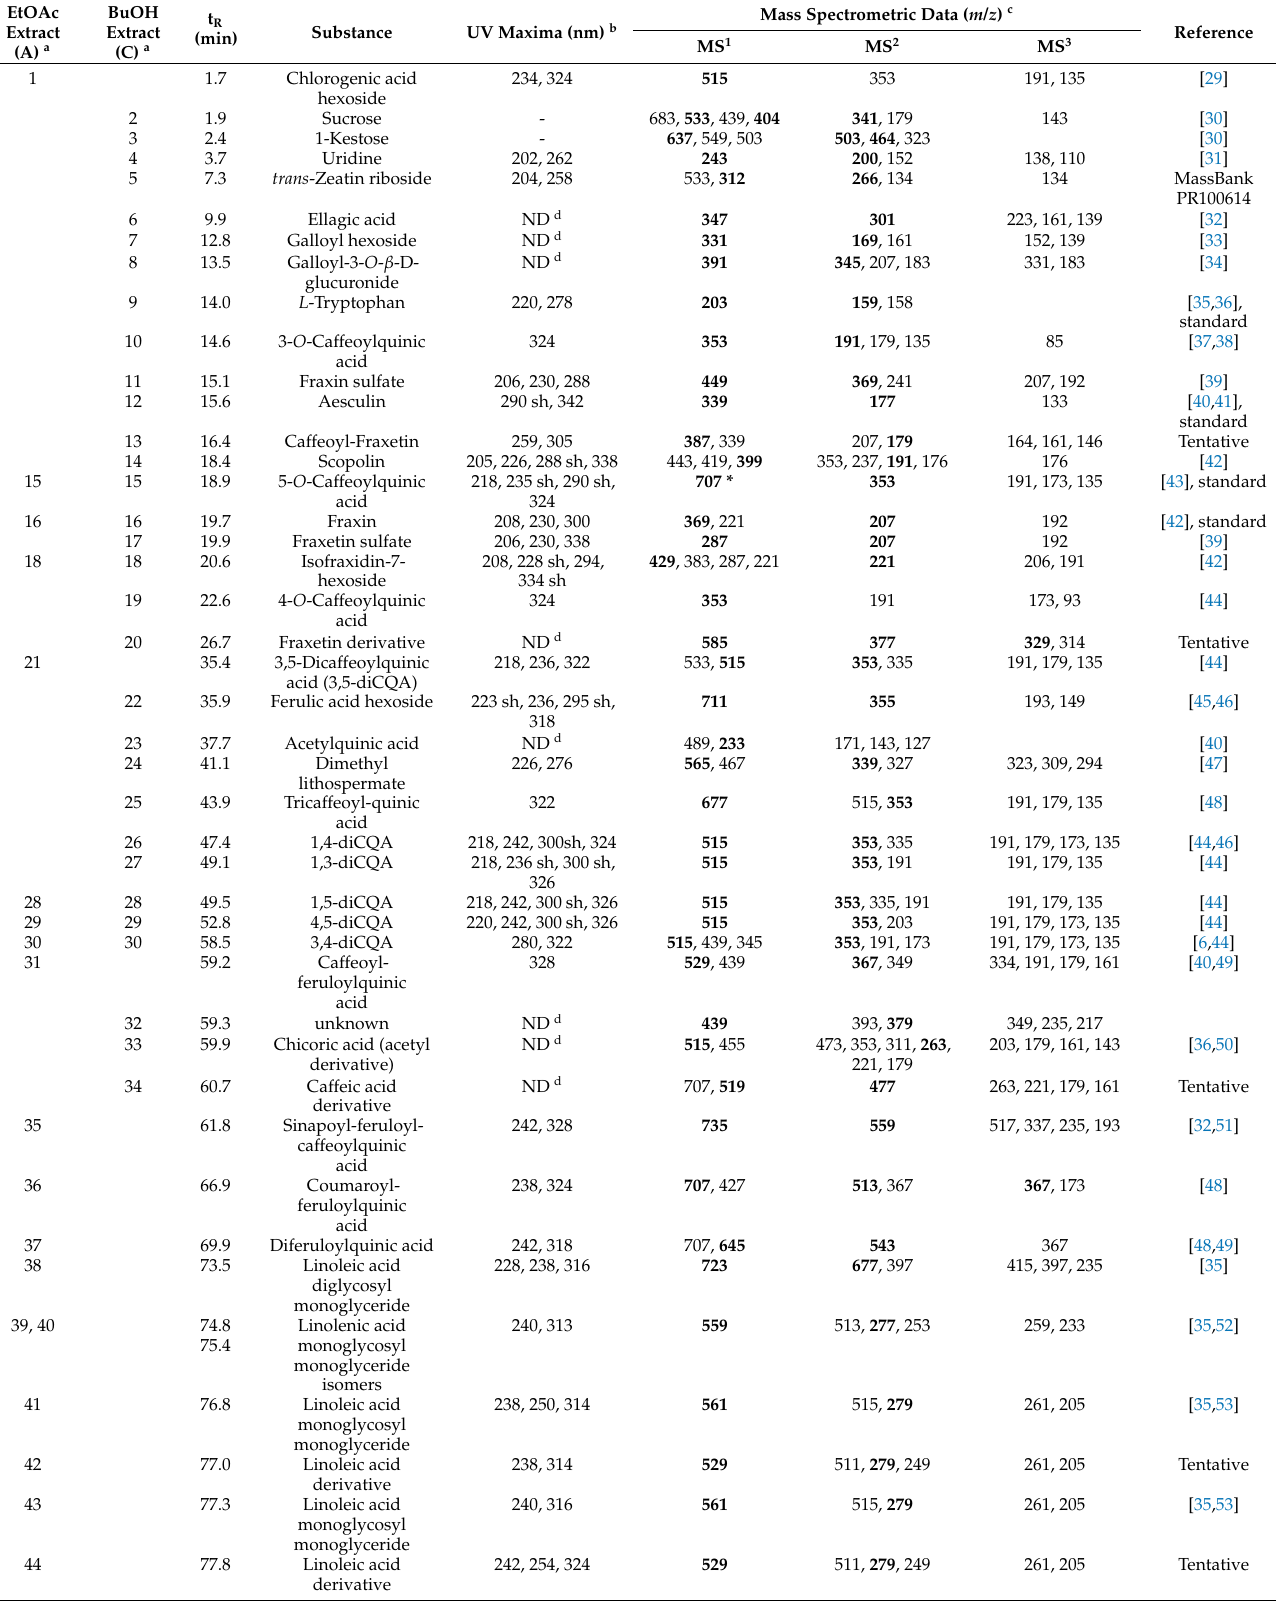
Table 2. HPLC-DAD-MS n data of compounds detected in ethyl acetate and n -butanol extracts of M. recutita roots in negative ionization